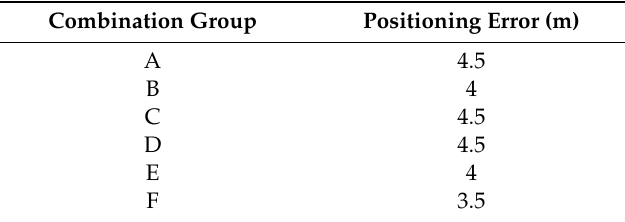
Table 4. Positioning errors comparison of di ff erent combination groups at the 90% CDF in experimental environment.